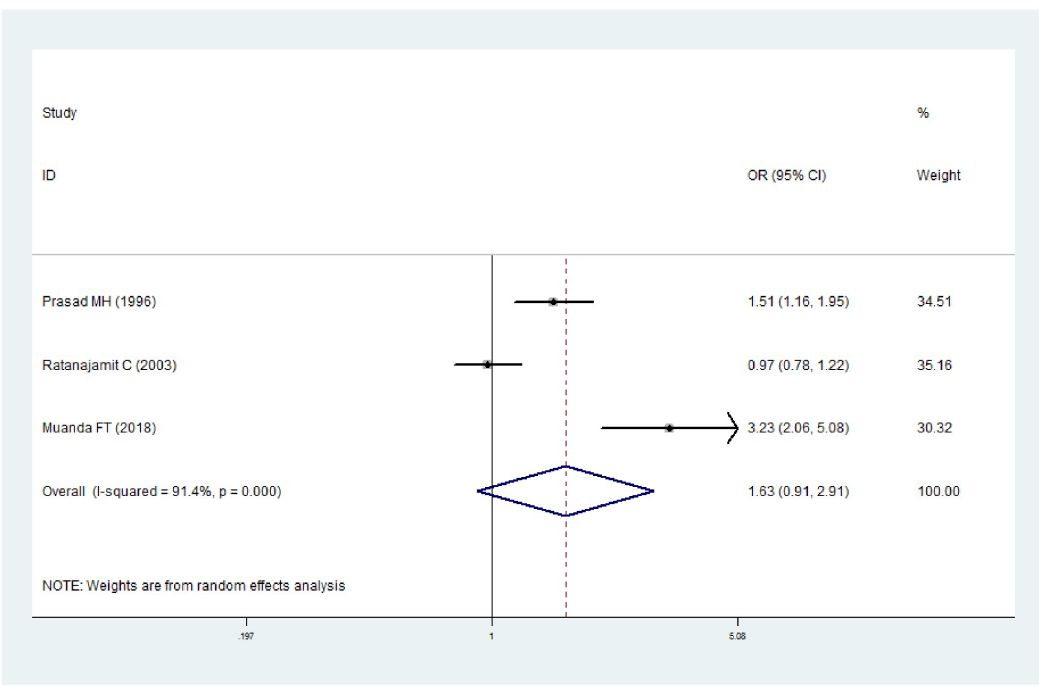
Fig 5. Forest plot with pooled odds ratios of the effect of maternal exposure to sulfonamides on spontaneous abortion.